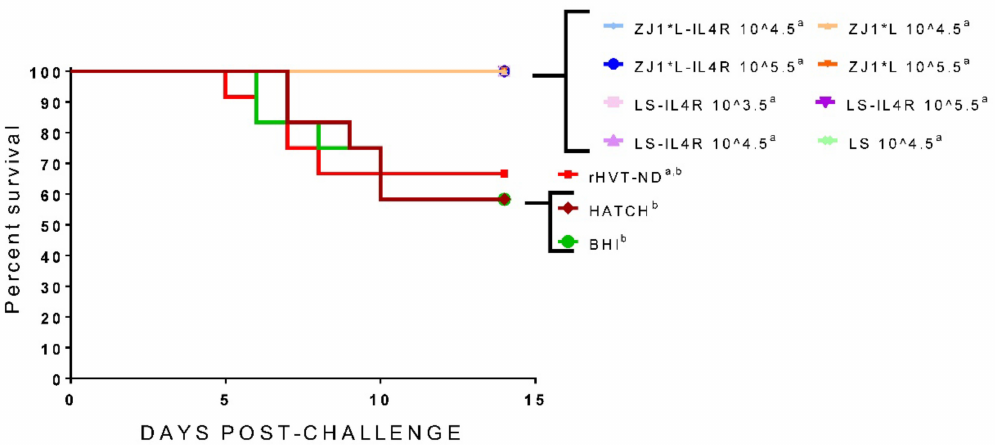
Figure 4. Survival of chickens after inoculation of commercial eggs at 18 days of embryonation with experimental in ovo vaccines and early challenge with virulent Newcastle disease virus at 14 days post-hatch. Birds were monitored for 14 days post-challenge. Different superscript letters indicate statistically significant differences between groups ( p value < 0.05). Group abbreviations: HATCH—eggs not inoculated; BHI—eggs inoculated with BHI; rHVT-ND—eggs inoculated with recombinant HVT vaccine; ZJ1*L—eggs inoculated with the recombinant ZJ1*L virus whose cleavage site was modified to be of low virulence; ZJ1*L-IL4R—eggs inoculated with the recombinant low virulent ZJ1*L with the interleukin-4 gene inserted in reverse orientation; LS—eggs inoculated with the LaSota strain; LS-IL4R—eggs inoculated with the recombinant LaSota virus with the interleukin-4 gene inserted in reverse orientation. The virus dose that the eggs in each group received is represented as a number after the group name in EID 50 /per